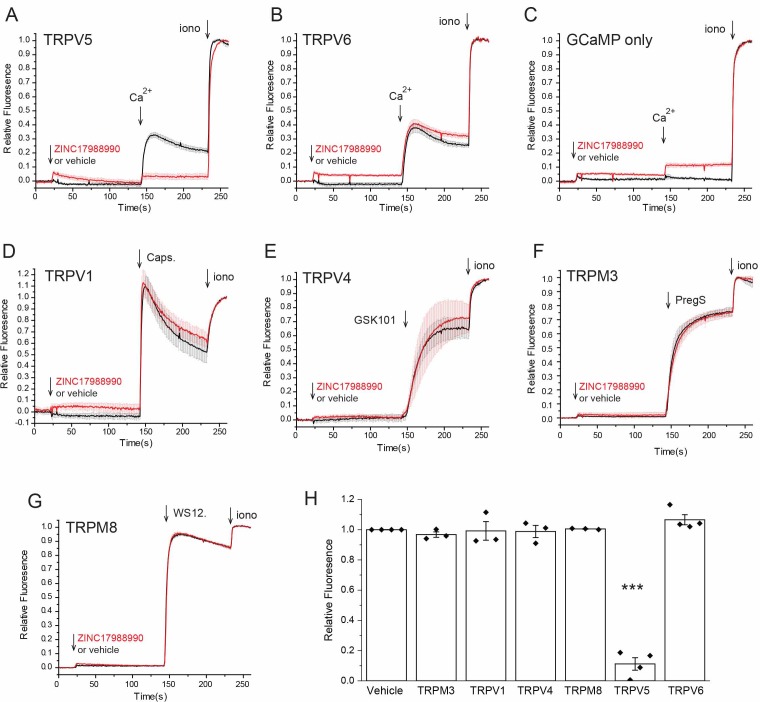
Effect of ZINC17988990 on TRP channel mediated calcium flow.Intracellular Ca2+ measurements were performed as described in the methods section, using a Flexstation three plate reader. HEK293 cells were transiently transfected with the genetically encoded Ca2+ indicator GCaMP6 and rbTRPV5 (A), hTRPV6 (B), pCDNA3 (C), rTRPV1 (D), rTRPV4 (E), mTRPM3α2 (F) and rTRPM8 (G). For all panels the baseline fluorescence was subtracted first, then all traces were normalized to the maximal fluorescence after the application of ionomycin; the traces show mean ± SEM from three, or four different plates from independent transfections. Application of 10 μM ZINC17988990 or equivalent volume of DMSO (0.033%) at 20 s is indicated by the first arrow. For panels A-C the cells were initially kept in a divalent free solution, and the second arrow indicates the application of 2 mM Ca2+. For panels D-G the cells were kept in a solution containing 2 mM Ca2+, and the second arrow indicates the application of the agonist of the TRP channel tested: 1 μM capsaicin for TRPV1 (D), 100 nM GSK1016790A for TRPV4 (E), 50 μM pregenolone sulfate for TRPM3 (F) and 5 μM WS12 for TRPM8 (G). The third arrow in each panel show the application of the Ca2+ ionophore ionomycin (2 μM). (H) Statistical summary normalized to the relative fluorescence increase induced by the TRP channel agonist or Ca2+ in vehicle treated cells. ***<0.001 (t-test).